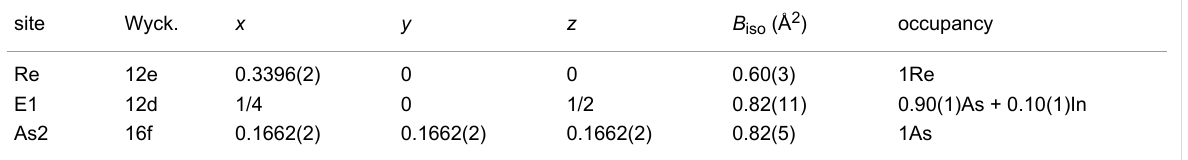
Table 2: Atomic coordinates and displacement parameters for S1 . site